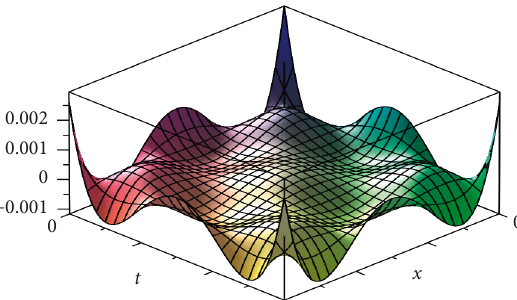
Figure 4: The approximate solution of u